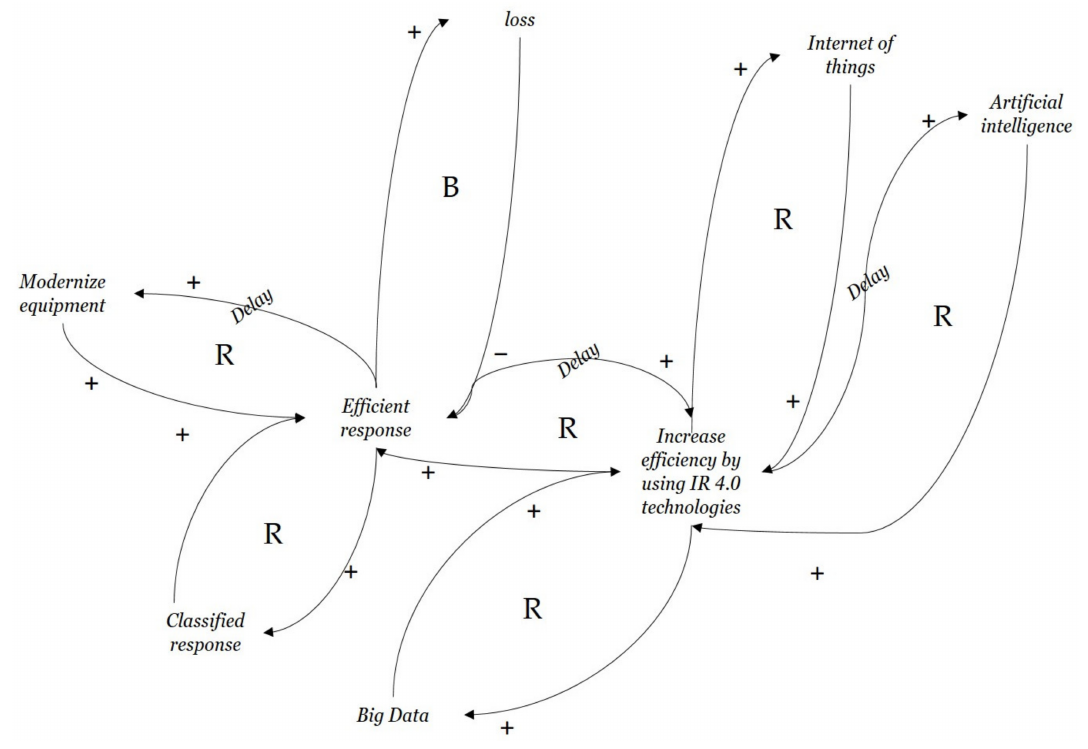
Figure 4. Response